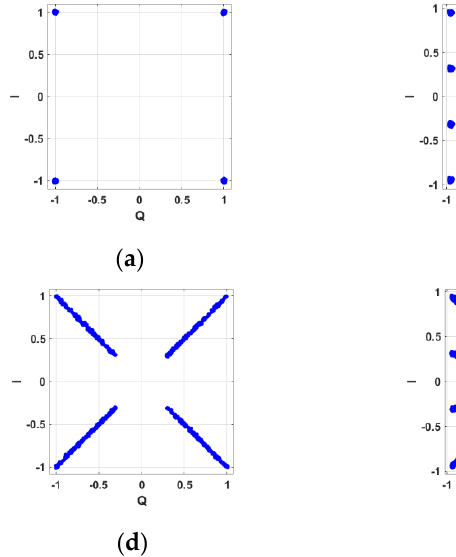
( c ) Figure 10. BER simulation results (fixed I p and varying I m ) for ( a ) QPSK, ( b ) 16QAM, and ( c ) 64QAM. 6.2. SDR Performance Evaluations The environmental set-up of the SDR transceiver experiment is shown in Figure 11. It consisted of a transmitter, a laptop that controlled the SDR transmitter, a receiver, and a laptop that controlled the SDR receiver. The laptop used an Intel Core i7-8750H proces- ser and 16 GB RAM. The utilized SDRs were Ettus USRP B210. In addition, to minimize the external noise effect, we connected the RF port via a cable during the performance evaluation experiments. The details of the SDR configuration set-up are shown in Table 1. Figure 11. SDR performance evaluation experiment set-up. Table 1. SDR configuration parameters. Parameter Name Parameter Values Center frequency 915 MHz Bandwidth 1 MHz